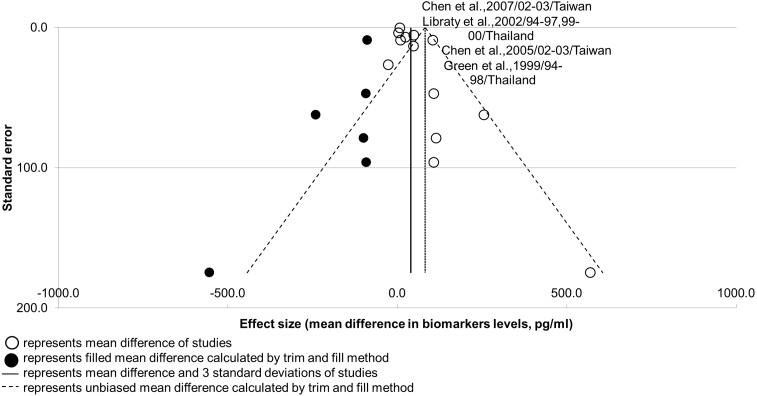
Funnel plot for potential biomarker IL-10.Shape of funnel plot showed obvious asymmetry. Unbiased mean difference calculated from trim and fill method was significantly different from the original estimate (p-value < 0.05). Two pair of studies presented with an overlap of five to seven co-authors, as well as study durations and locations.